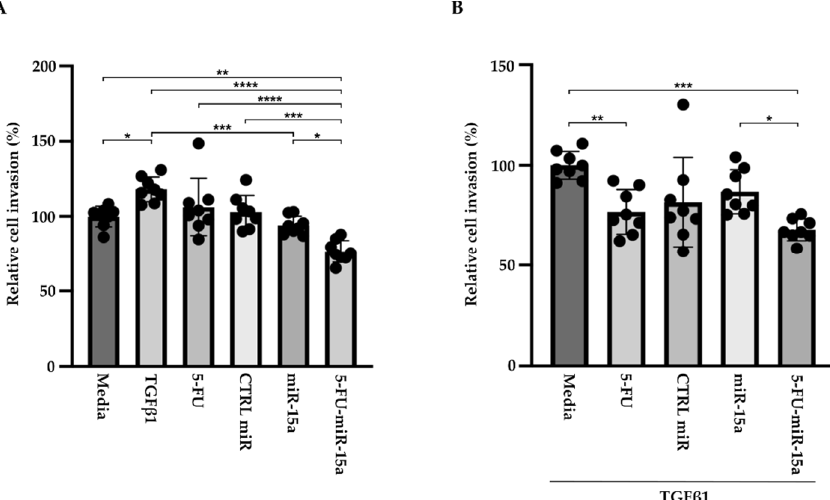
Figure 8. 5-FU-miR-15a medium obtained from pancreatic stellate cells reduced invasion of pancre- atic cancer cells (KPC). Pancreatic cancer cells were exposed to conditioned media obtained from pancreatic stellate cells treated with TGF β 1, and/or 5-FU, CTRL miR, miR-15a, and 5-FU-miR-15a. The invasion was assessed 22 h post-treatment with ( A ) media obtained from pancreatic stellate cells after single agent treatment and ( B ) media obtained from pancreatic stellate cells co-treated with TGF β 1. Data are represented as the mean ± SD, N = 8. * p < 0.05, ** p < 0.01, *** p < 0.001, and **** p < 0.0001 by one-way ANOVA.